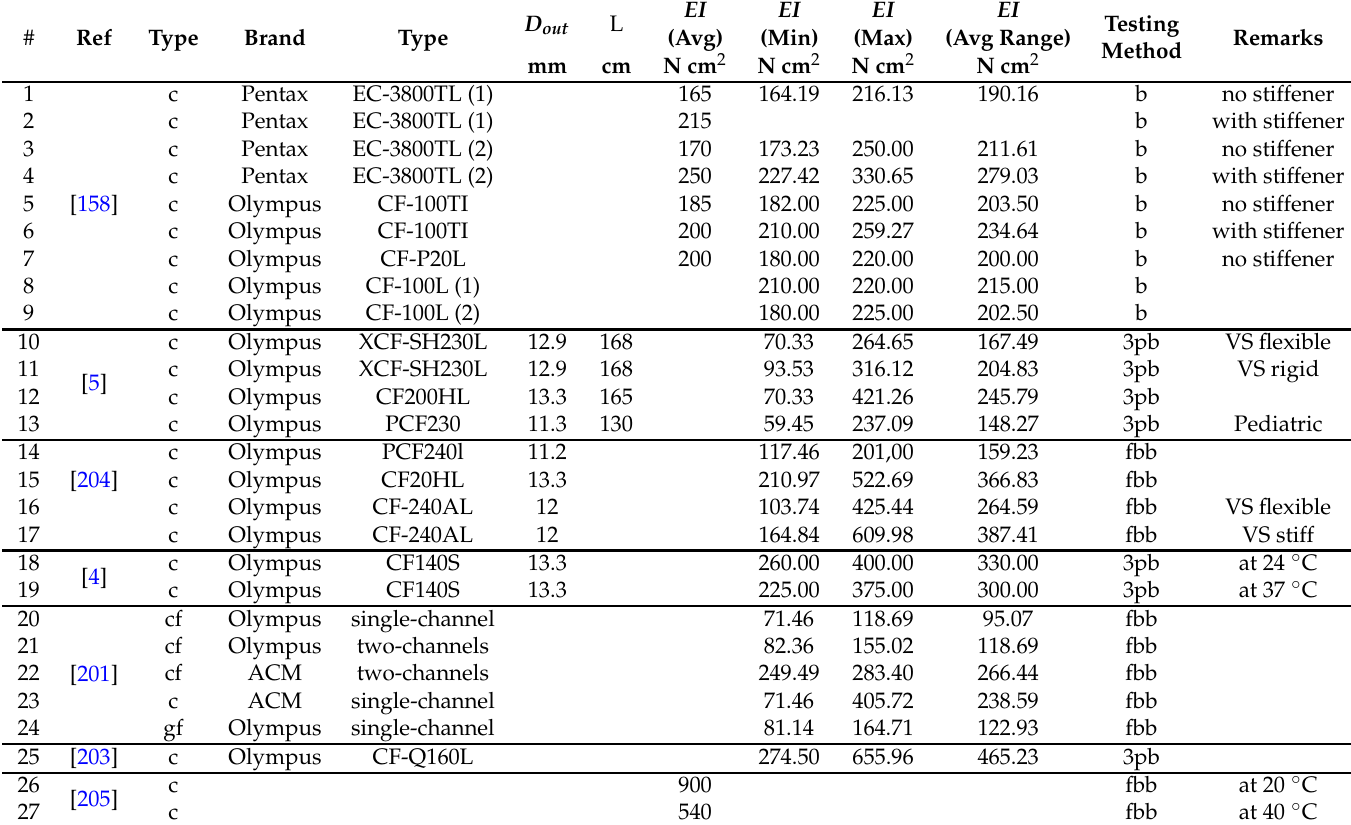
Table A1. Compilation of endoscopic stiffness measured in the literature for several type of endoscopic devices (c = colonoscope, cf = colonofibroscope, gf = gastrofibroscope). Various bending test methods have been implemented (3pb = three-point bending, b = buckling, fbb = fixed beam bending). “VS” stands for “Variable Stiffness device”, “avg” for “global average”, “avg range” for “average over the minimal and maximal